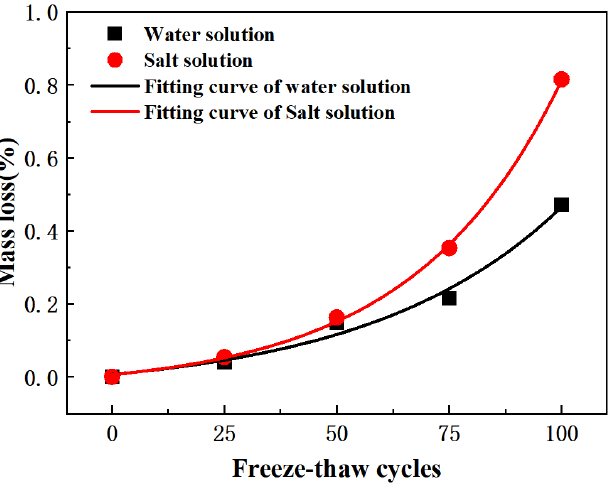
Figure 10. Fitting curve of mass loss of permeable concrete under freeze-thaw cycles.